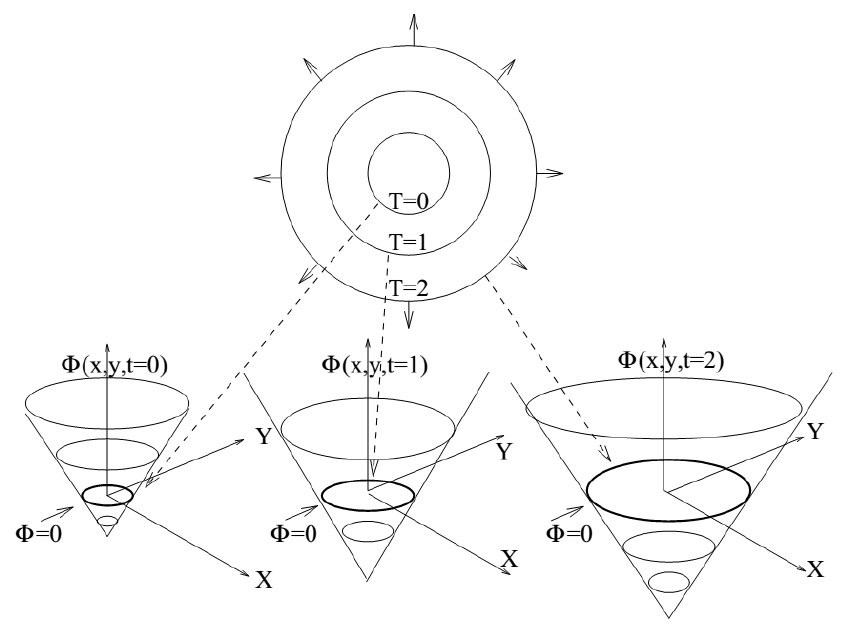
Figure 5. Transformation of front motion into initial value